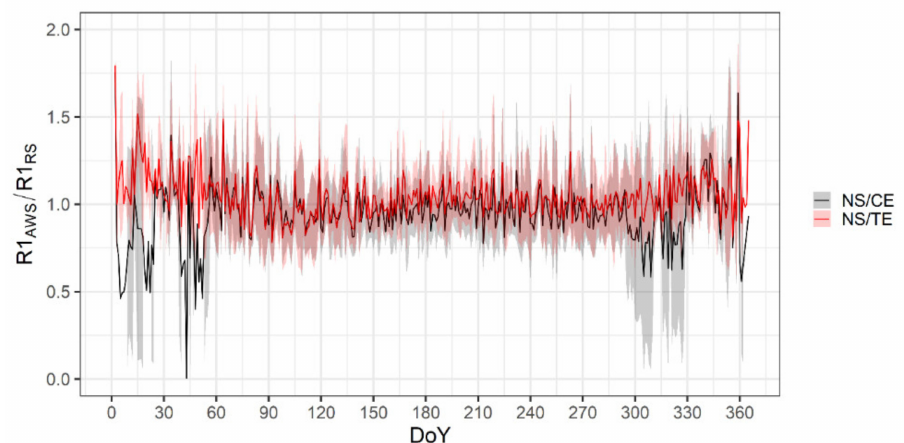
Figure 15. Seasonal variation of R 1 ratio between orchard (black) and crop canopy (red) with respect to RS climate station.